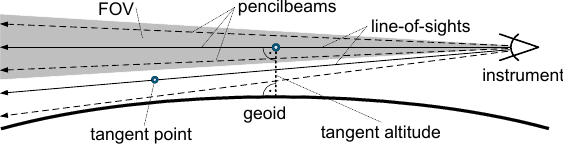
Fig. 3. Diagram of observation geometry. The CRISTA-NF instrument is located to the right. Line-of-sight of radiance measurements are shown as straight lines. Additional pencilbeams are shown as dotted lines. The FOV of one measurement is shown as a grey cone (not to scale).